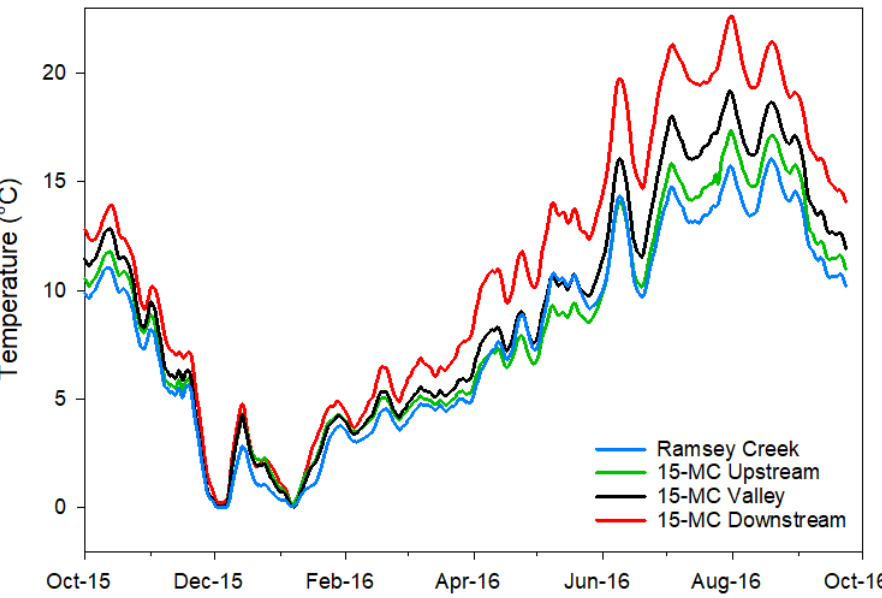
Figure 8. Seven-day running average (7DA) stream temperature at the four sites from October 2015 to September 2016.